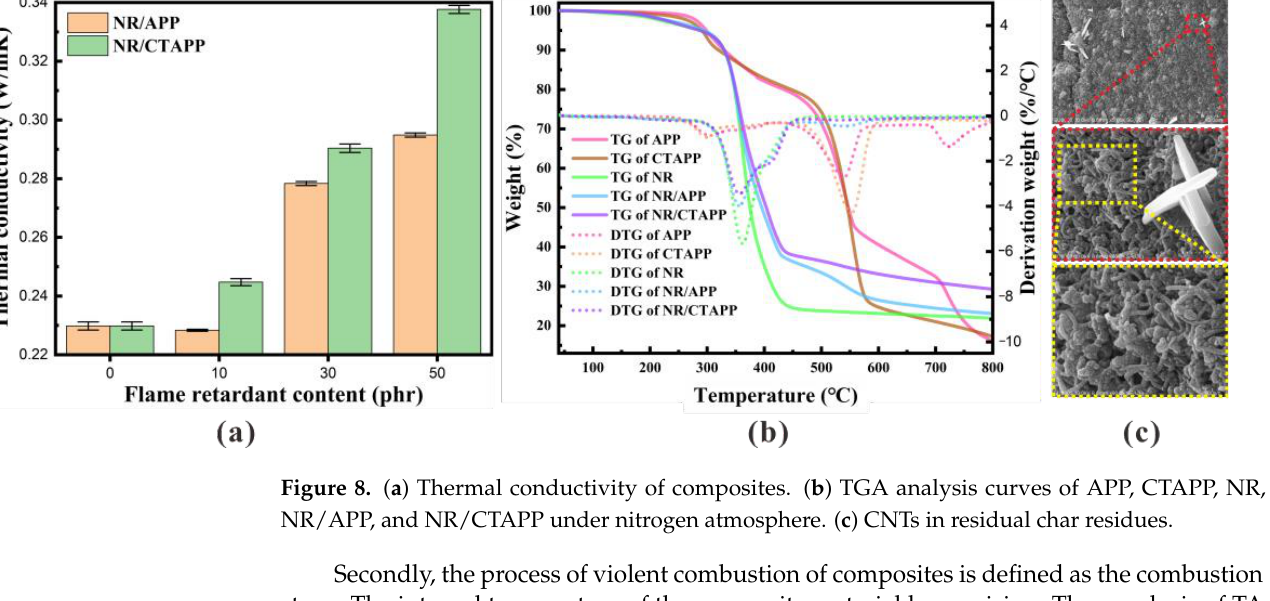
NR/APP, and NR/CTAPP under nitrogen atmosphere. ( c ) CNTs in residual char residues.